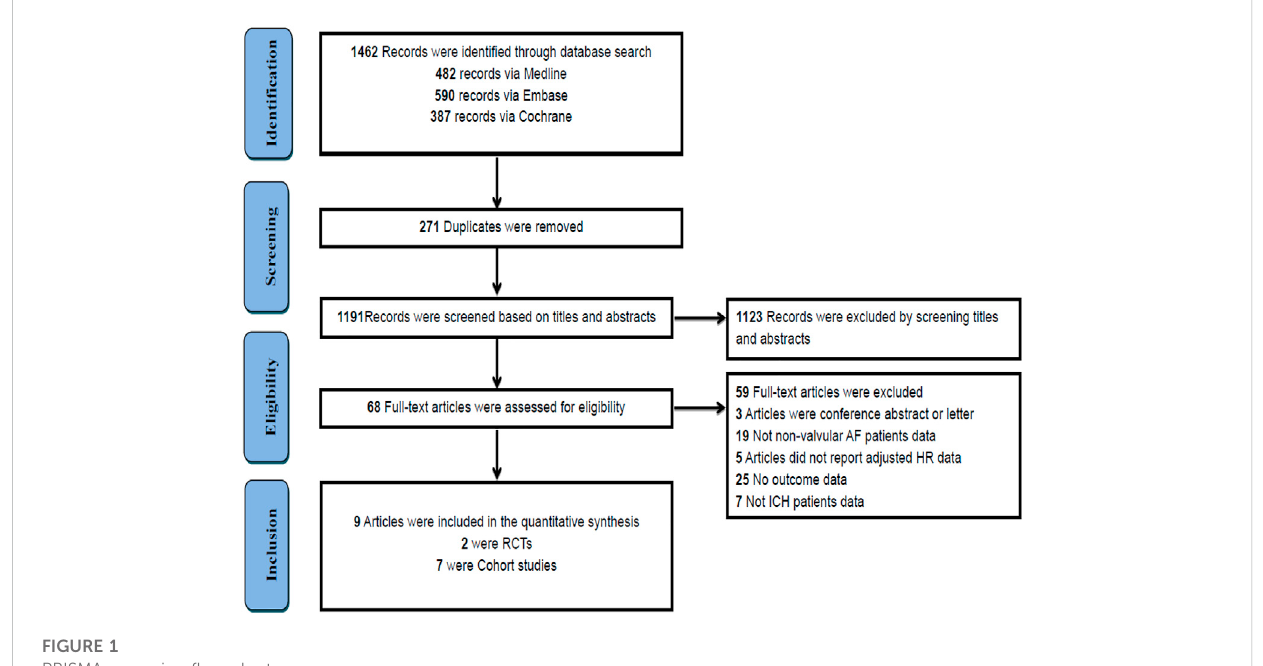
FIGURE 1 PRISMA screening fl ow